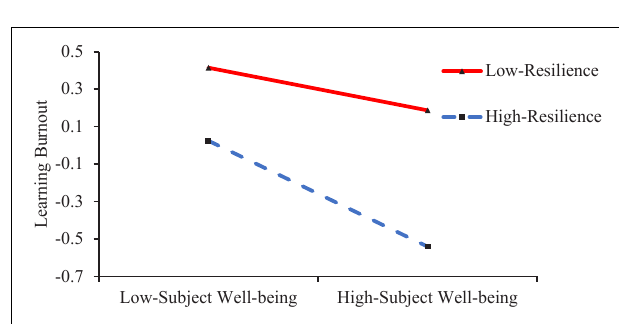
FIGURE 3 | Moderating role of resilience in the relationship between subjective well-being and learning